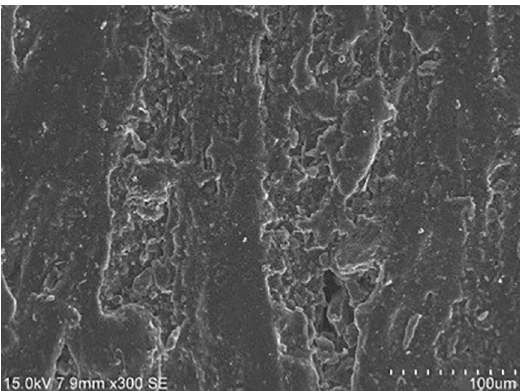
Figure 10. Image of the fractured surface of short carbon fiber reinforced polyester type of manner. Figure 10 indicates the fiber orientation using mould go with the flow polyseter insight for the moulded leaf spring where fiber turned into orientated alongside the leaf because the load is appearing ordinary to the fiber